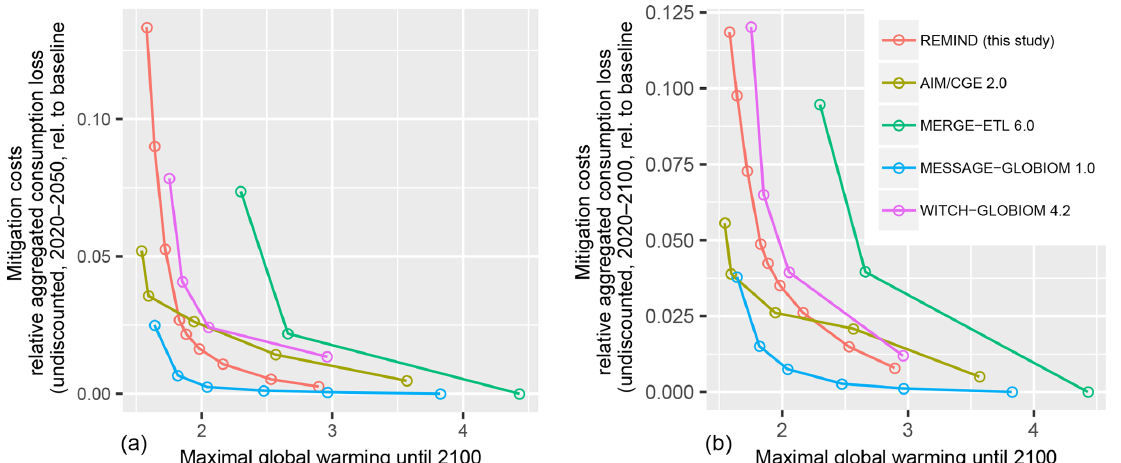
Figure A6. Comparison of REMIND mitigation costs used in this study with recent results of all models reported in the public dataset of the IPCC SR1.5 scenario database (Huppmann et al., 2018) used in the IPCC special report on 1.5 ◦ C. Mitigation cost curves are shown as a function of maximal global warming (until 2100). The costs are aggregated consumption losses relative to a baseline scenario (undiscounted for 2020–2050 a and 2020–2100 b ). The scenarios are filtered such that delayed action scenarios and constrained technology portfolio scenarios are